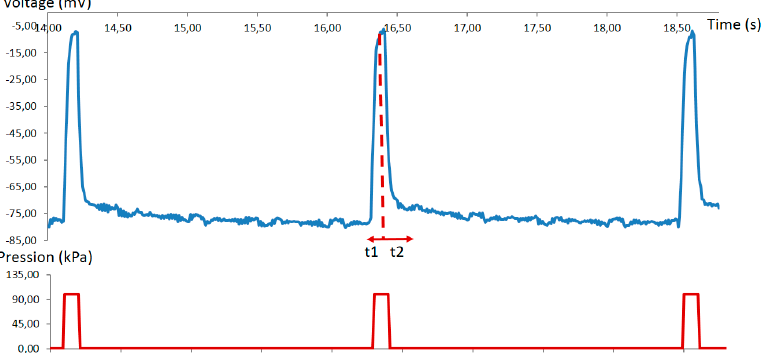
Figure 13. In blue, action potentials of the microfluidic neuron; in red, air pressure pulses. The action potential are created by the Quake valve using air pressure: 100 ms duration and 100 kPa pressure. Pulses are created at 14.1, 16.3 and 18.4 s. Action potential has an average amplitude of 75 mV, similar to biological neuron amplitude.